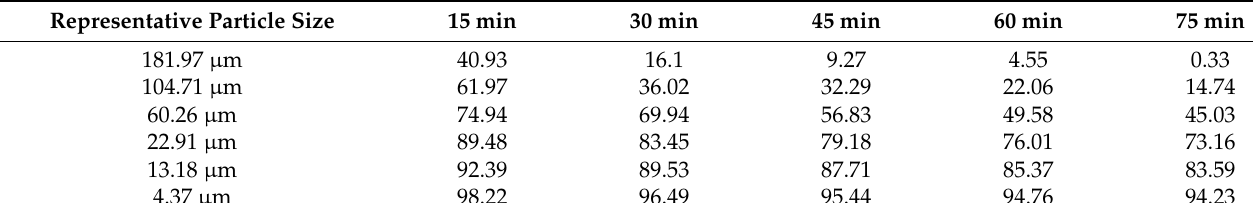
Table 2. The sieve allowance of six representative particle sizes of CGS.